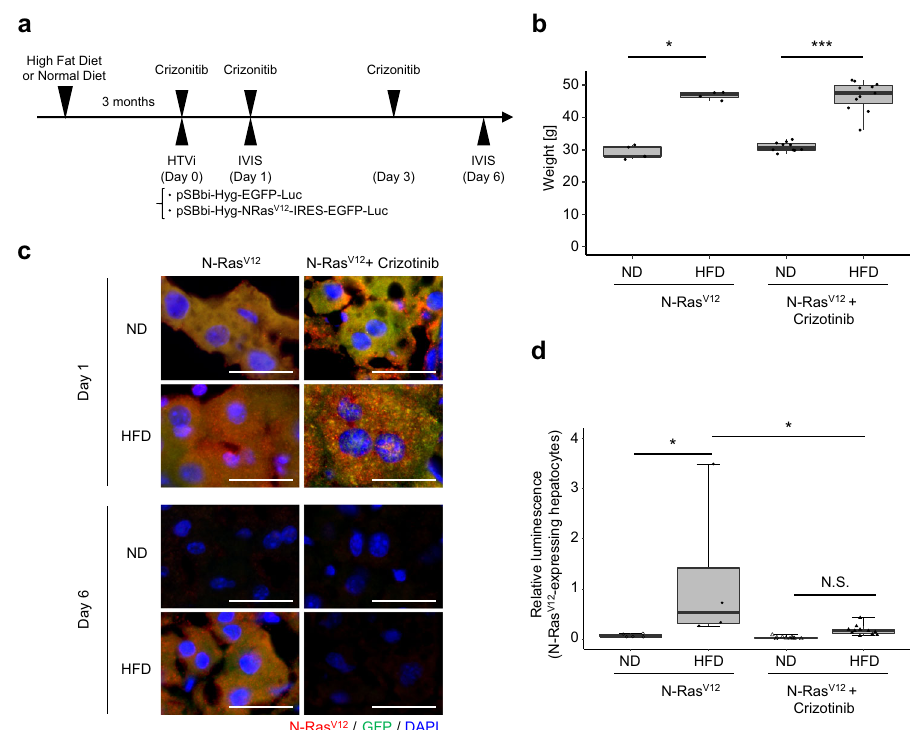
Fig. 4 Crizotinib improves the ef fi ciency of cell competition in HFD-fed mouse liver. a Timeline of the experimental procedure. C57BL/6 mice were fed ND or HFD for 3 months and subjected to HTVi with empty control or plasmid-encoding GFP-N-Ras V12 -IRES-luciferase (N-Ras V12 , n = 5 (ND), n = 4 (HFD); N-Ras V12 + Crizotinib, n = 10 (ND), n = 11 (HFD)). Some HFD-fed mice were orally administered 50 mg/kg crizotinib thrice. The mice were euthanized and subjected to in vivo bioluminescent imaging to con fi rm the GFP-N-Ras V12 -IRES-luciferase expression at days 1 and 6. b The average body weight of each group on day 6 in ( a ) (N-Ras V12 , n = 5 (ND), n = 4 (HFD); N-Ras V12 + Crizotinib, n = 10 (ND), n = 11 (HFD)). N-RasV12: HFD vs ND, P = 0.016, N-RasV12 + Crizotinib: HFD vs ND, P < 0.001. c Immuno fl uorescence analysis of liver sections stained using N-Ras (red) and cell nuclei stained using DAPI (blue). Scale bar, 20 μ m. d The values of relative luminescence in each group (see “ Methods ” ). The relative luminescence was normalized by the mice subjected to HTVi with empty control and ND-fed mice. HFD (N-Ras V12 ) vs (ND) N-Ras V12 , P = 0.017; HFD (N-Ras V12 ) vs HFD (N- Ras V12 + Crizotinib), P = 0.013. * P < 0.05, *** P < 0.001, or not signi fi cant (N.S.) by Wilcoxon rank-sum test ( b ), or one-way ANOVA, followed by Tukey ’ s multiple comparisons posthoc test ( d